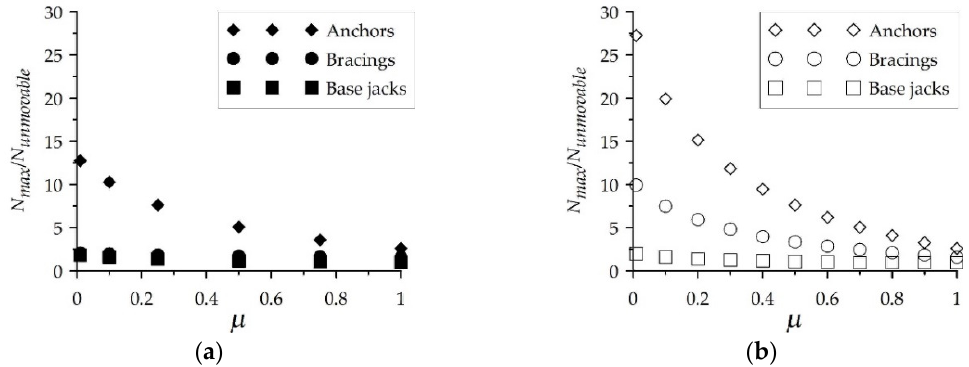
Figure 8. Maximum normal forces depending on the μ value with ground heterogeneity in a direction: perpendicular to the facade ( a ); parallel to the façade ( b ).